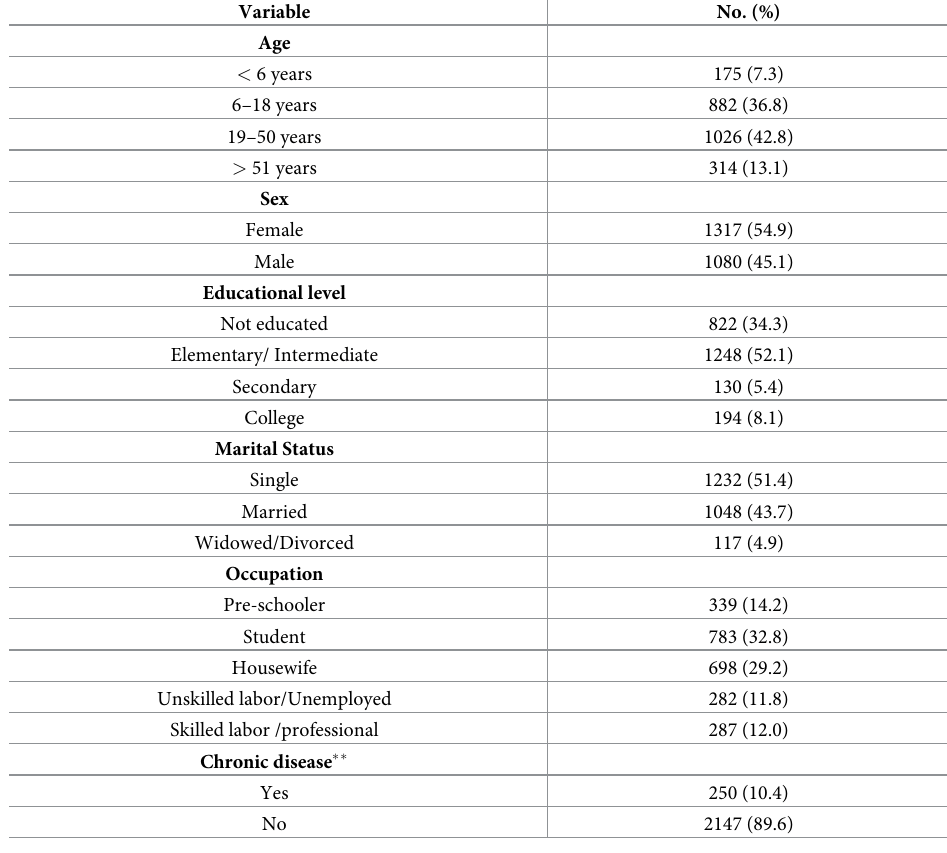
Table 1. Distribution of demographic and health data of the study � participants, 2017–2019 in